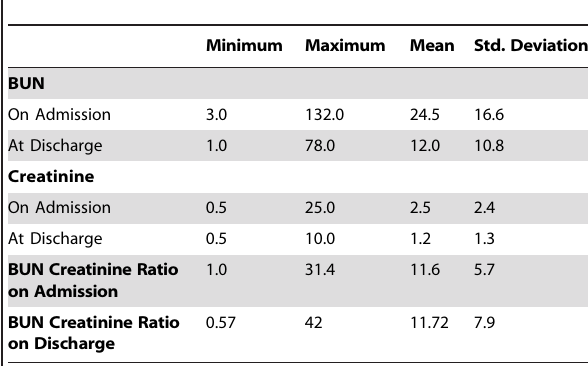
Table 3. Blood Urea Nitrogen and Creatinine levels and